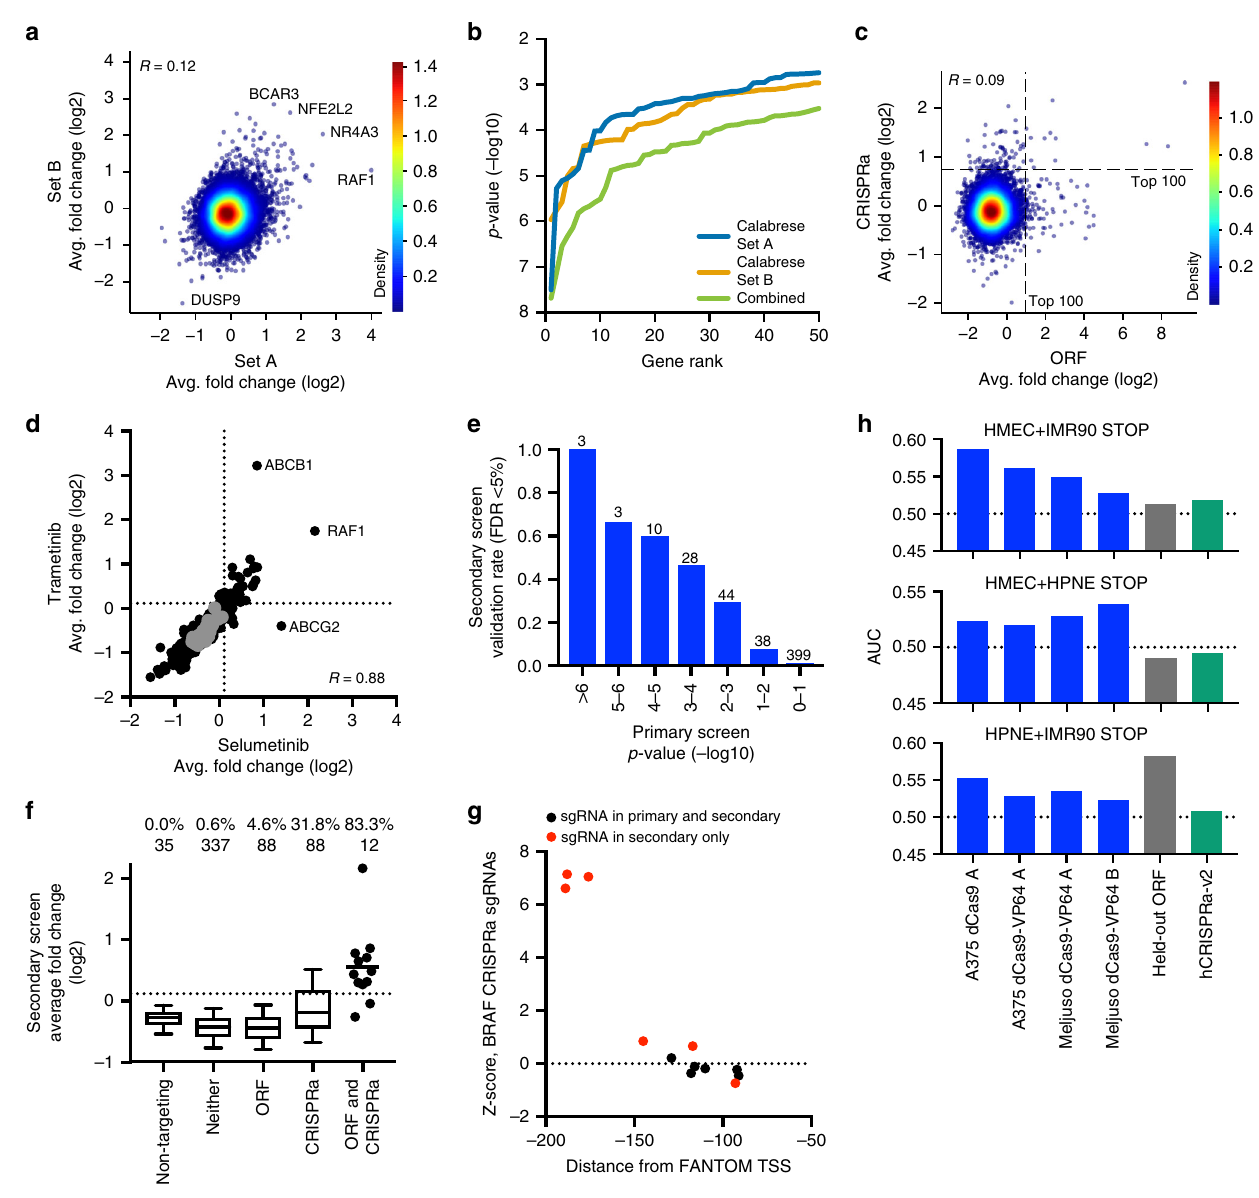
Fig. 6 Comparison of CRISPRa and ORF technology. a Comparison of log2-fold change values for Calabrese Set A and Set B. Each dot represents the average of the 3 sgRNAs per gene. Top scoring genes are annotated. b Distribution of the p -values for the top 50 genes in each set of Calabrese, as well as both sets combined, for selumetinib resistance screens in MelJuSo cells. P -values were calculated using a hypergeometric distribution equivalent to a one- sided Fisher ’ s exact test. c Comparison of log2-fold change for MEK inhibition screens in MelJuSo cells, for an ORF library screened with trametinib and the Calabrese library screened with selumetinib. Dotted lines indicate the top 100 genes in each screen. d Comparison of the average log2-fold change values for all sgRNAs targeting a gene in the secondary pool screened with either selumetinib or trametinib. Sets of non-targeting control sgRNAs are colored in gray; dotted lines represent a 5% FDR cutoff. e Validation rate of genes in the secondary screen grouped by their p -value in the primary screen (combined sets; see ( b )) for selumetinib resistance in MelJuSo cells. Number of genes per category is indicated. f Validation rate for genes grouped by the primary screen in which they scored. Dotted line indicates FDR <5%. The fraction of genes pass this cutoff is reported, as well as the total number of genes in each category. The box represents the 25th, 50th, and 75th percentiles; whiskers show 10th and 90th percentiles. For the category with 12 genes, the individual values are plotted and the mean indicated. g Secondary screen results for sgRNAs targeting BRAF . Black points are sgRNAs present in both the primary (Calabrese) and secondary pools; red points are sgRNAs that were only included in the secondary pool. h Area under the curve calculated for STOP genes in CRISPRa and held-out ORF screens. For each plot, a different ORF screen cell line (HMEC, IMR90, or HPNE) was held out, and the other two, indicated at the top of each graph, were used to generate a list of STOP